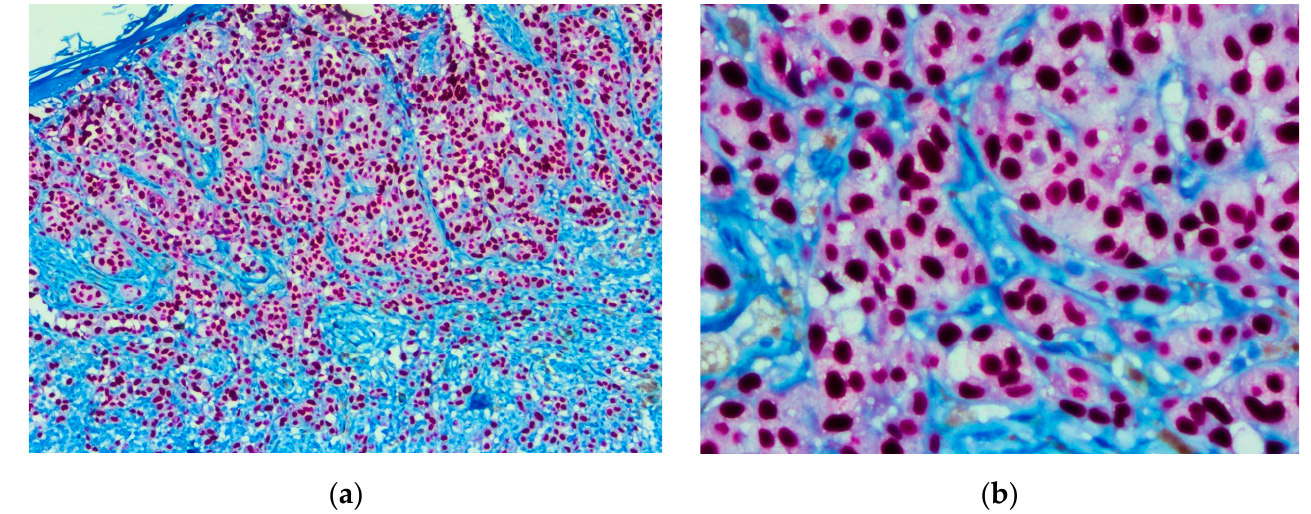
Figure 2. Nodular melanoma. ( a ) IHC stained with nuclear marker SOX10 (red chromogen), 5× mag- nification. ( b ) IHC stained with nuclear marker SOX10 (red chromogen), 40× magnification. (Collec- tion of Pathology Department SCJ Mure ș ).